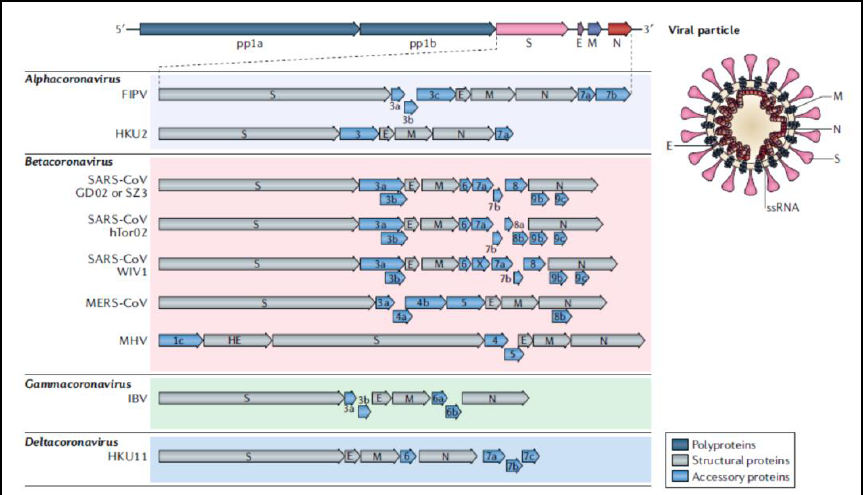
Fig. 1: The genomes, genes and proteins of different coronaviruses (Cui et al., 2019)